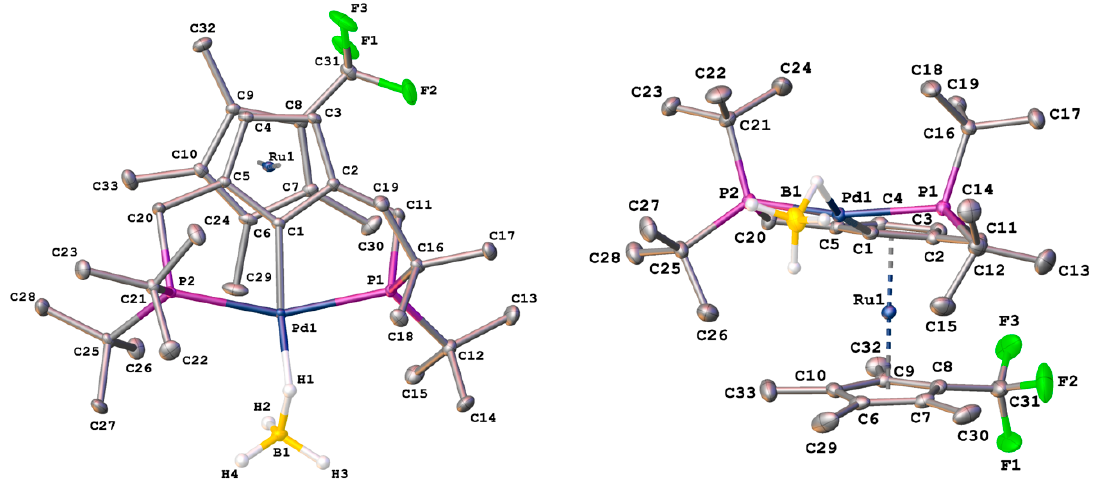
Figure 1. Two views of the compound 3a with thermal ellipsoids at 50% probability level. Selected bond lengths (Å) and angles (°): Pd(1)–C(1) 1.9844(18), Pd(1)–P(1) 2.3447(5), Pd(1)–P(2) 2.3679(5), Pd(1) ··· B(1) 2.531(2), Pd(1)–H(1) 1.86(2), Pd(1) ··· H(2) 2.46(2); C(1)–Pd(1)–H(1) 167.9(6), Pd(1)–H(1)–B(1) 110.2(12),